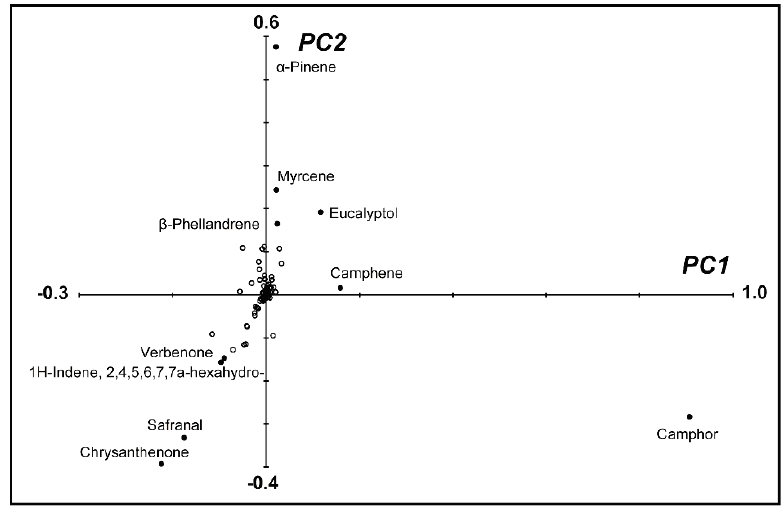
Figure 3. Loading plot of Eigenvector load values of 193 volatile components from PC1 and